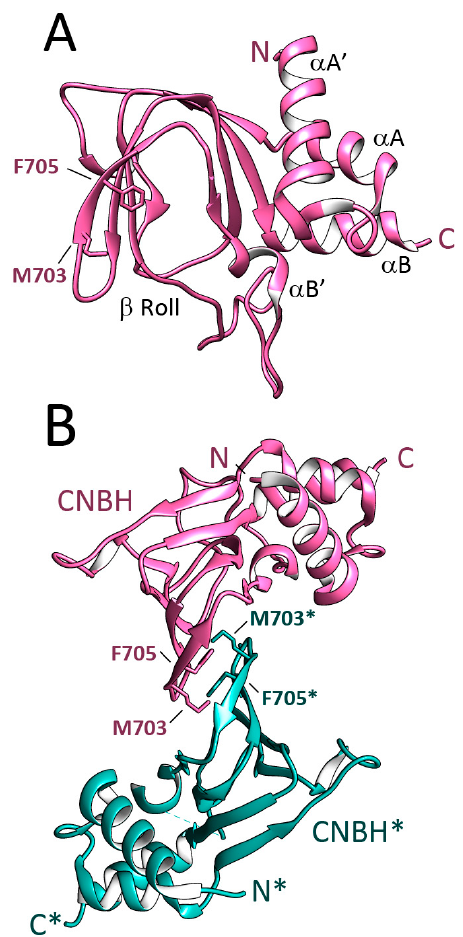
Figure 4. Crystal Structure of the CNBH of CNNM2. (Figure prepared using atom coordinates from PDB code 6DJ3 [59]. ( A ) The structure shows a central eight-stranded β roll preceded by two α -helixes in the N-terminal part ( α A’ and α A), and is followed by a C-terminal α helix called α B. The small α B helix is inserted in the beta roll. Residue F705 and some other bulky residues autoinhibit the domain and impair nucleotide binding [59]; ( B ) The CNBH domain associates in dimers. The complementary subunits are depicted in pink and green. Residues F705 and M703 are relevant in the subunits association.